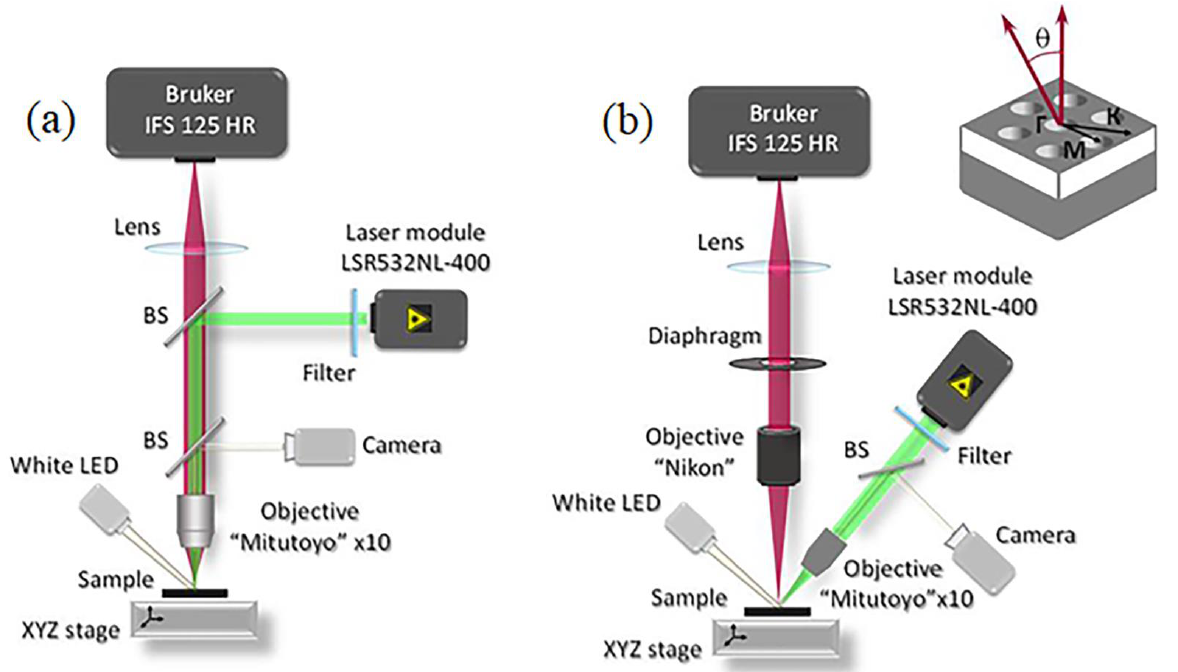
Figure 2. Schematics view of ( a ) the micro-photoluminescence (micro-PL) and ( b ) the directional photoluminescence (DPL) setups. BS in the figures—beam splitters. A hexagonal photonic crystal, it’s the high symmetry directions and the signal collection angle Θ are schematically shown in the upper right